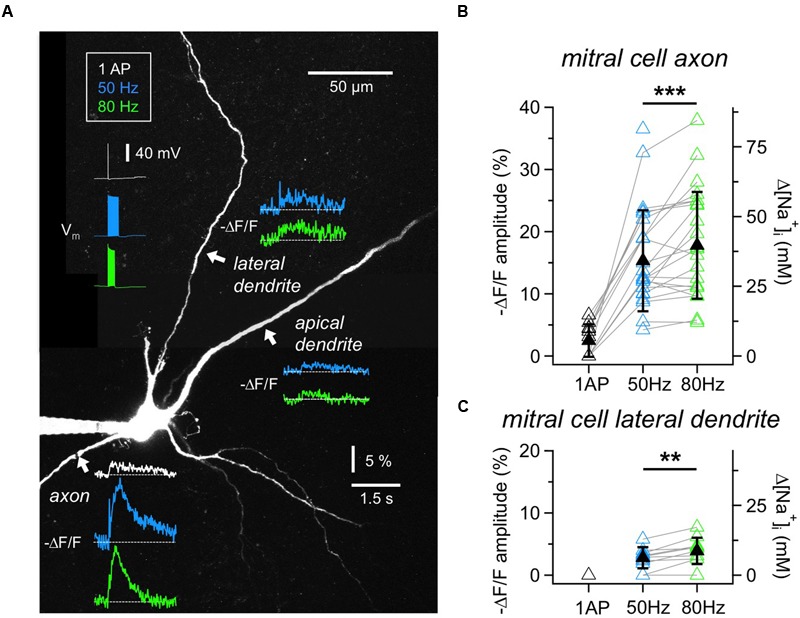
Na+ signals in MC axons and dendrites. (A) Two-photon scan of a representative MC filled with 1 mM SBFI. Averaged voltage traces of the three stimulation protocols (1 AP, 20 APs at 50 or 80 Hz, train duration 400 ms or 250 ms) as recorded from the soma are shown in the upper left. Averaged fluorescence transients were imaged at the locations indicated with white arrows. Fluorescence changes in response to single APs could only be detected in the axon. (B) Cumulative ΔF/F amplitude data for MC axons (n = 26 cells) and (C) lateral dendrites (n = 12 cells). Open symbols: individual data, solid black symbols: averaged data ± SD. Data recorded from the same location are indicated by gray connecting lines. ∗∗P < 0.01; ∗∗∗P < 0.005.